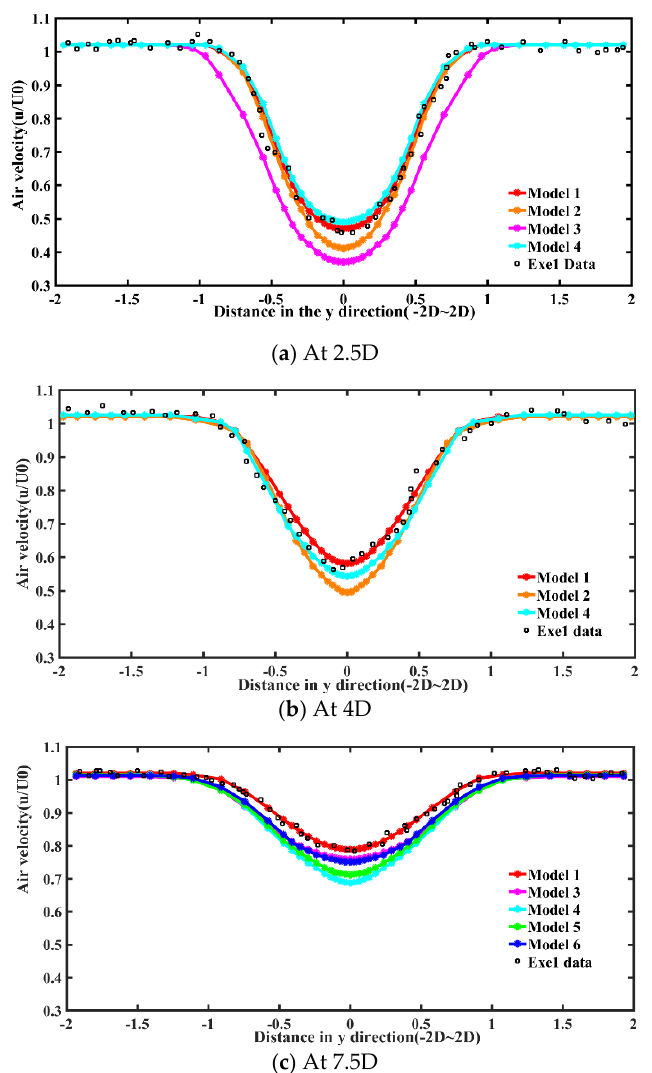
Figure 9. Correction velocity at the different cross-sections of axial direction.